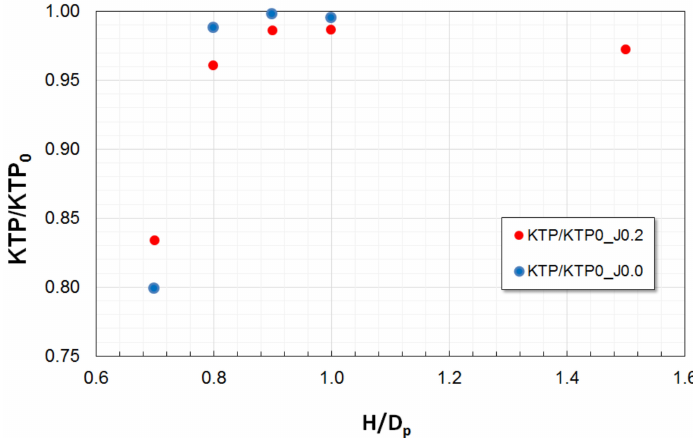
Figure 26. Variations in propeller thrust, KTP, with propulsor submergence, H/Dp, at J = 0.2 and J = 0.0. (KTP 0 refers to the corresponding value in unbounded flow).